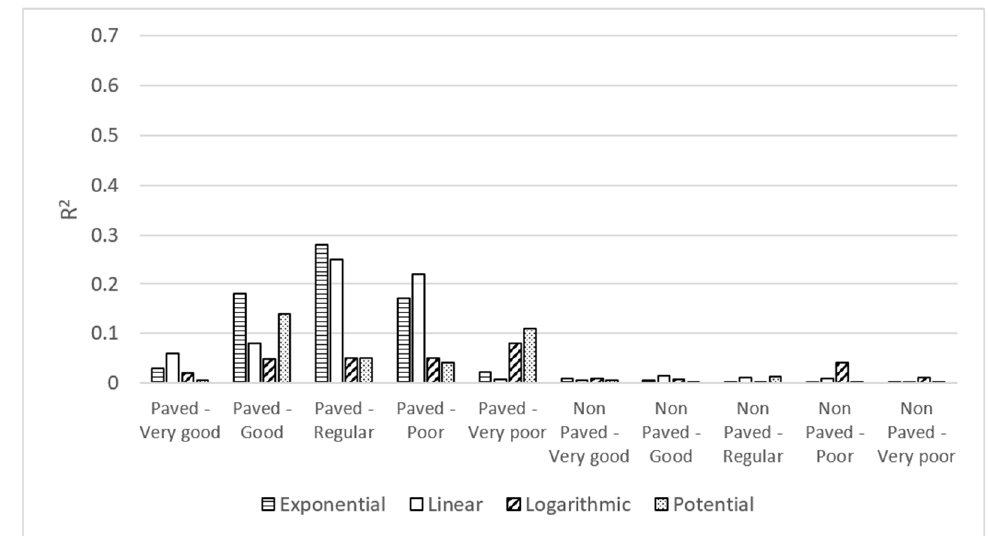
Figure 2. The R 2 value for regressions between departmental GDP and roadway network length according to condition.